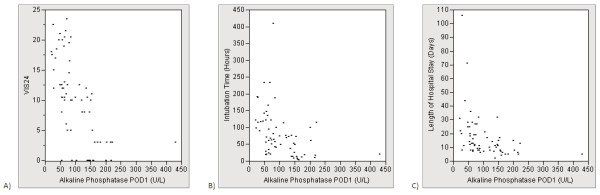
Scatter plot for alkaline phosphatase (AP) versus VIS24 (A), intubation time (B), and length of hospital stay (C).